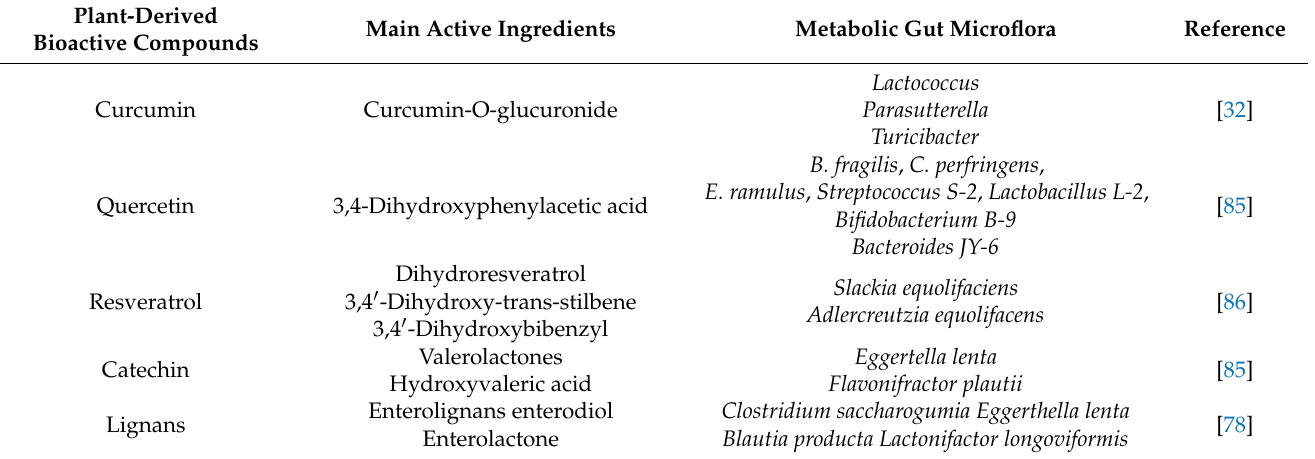
Table 1. Interactions between metabolites of gut microflora and plant-derived bioactive